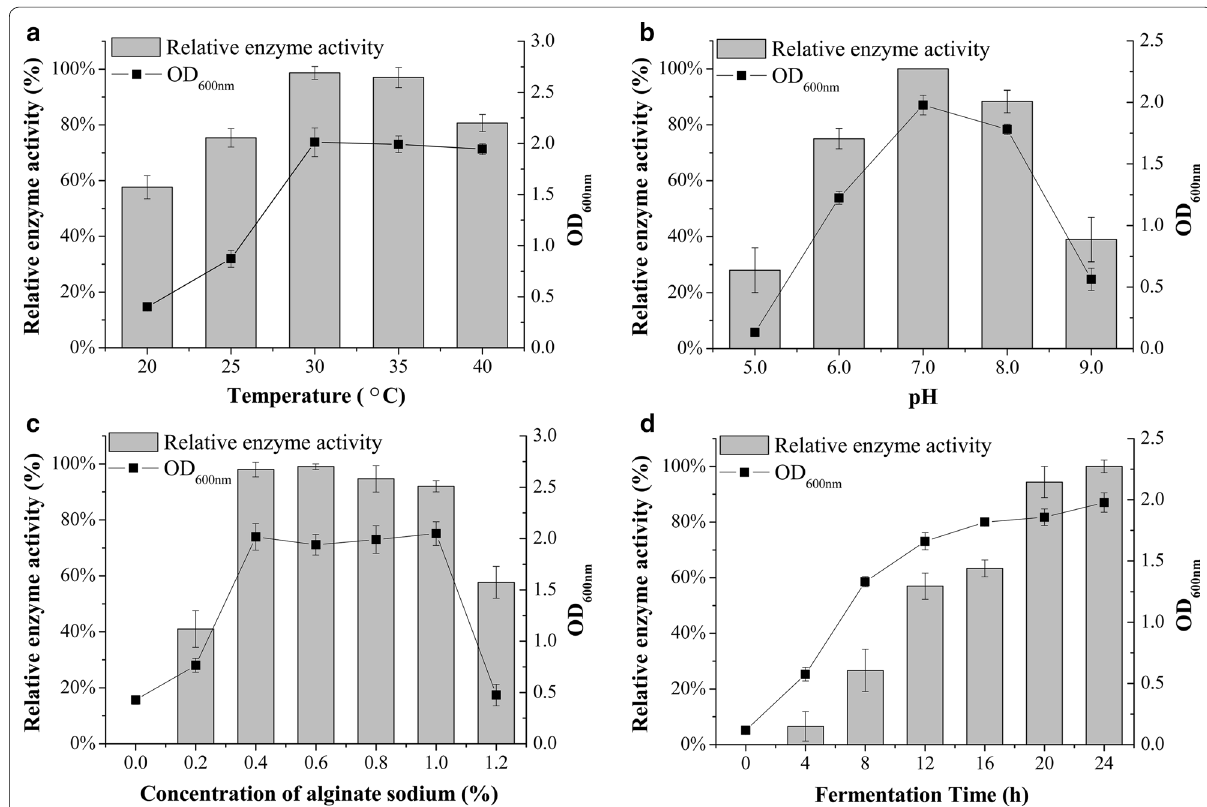
Fig. 4 Optimization of growth conditions for production of alginate lyase secreted by LJ-3 strain. a Temperature; b pH; c sodium alginate concen- tration and d fermentation time. Each value represents the mean of three replicates